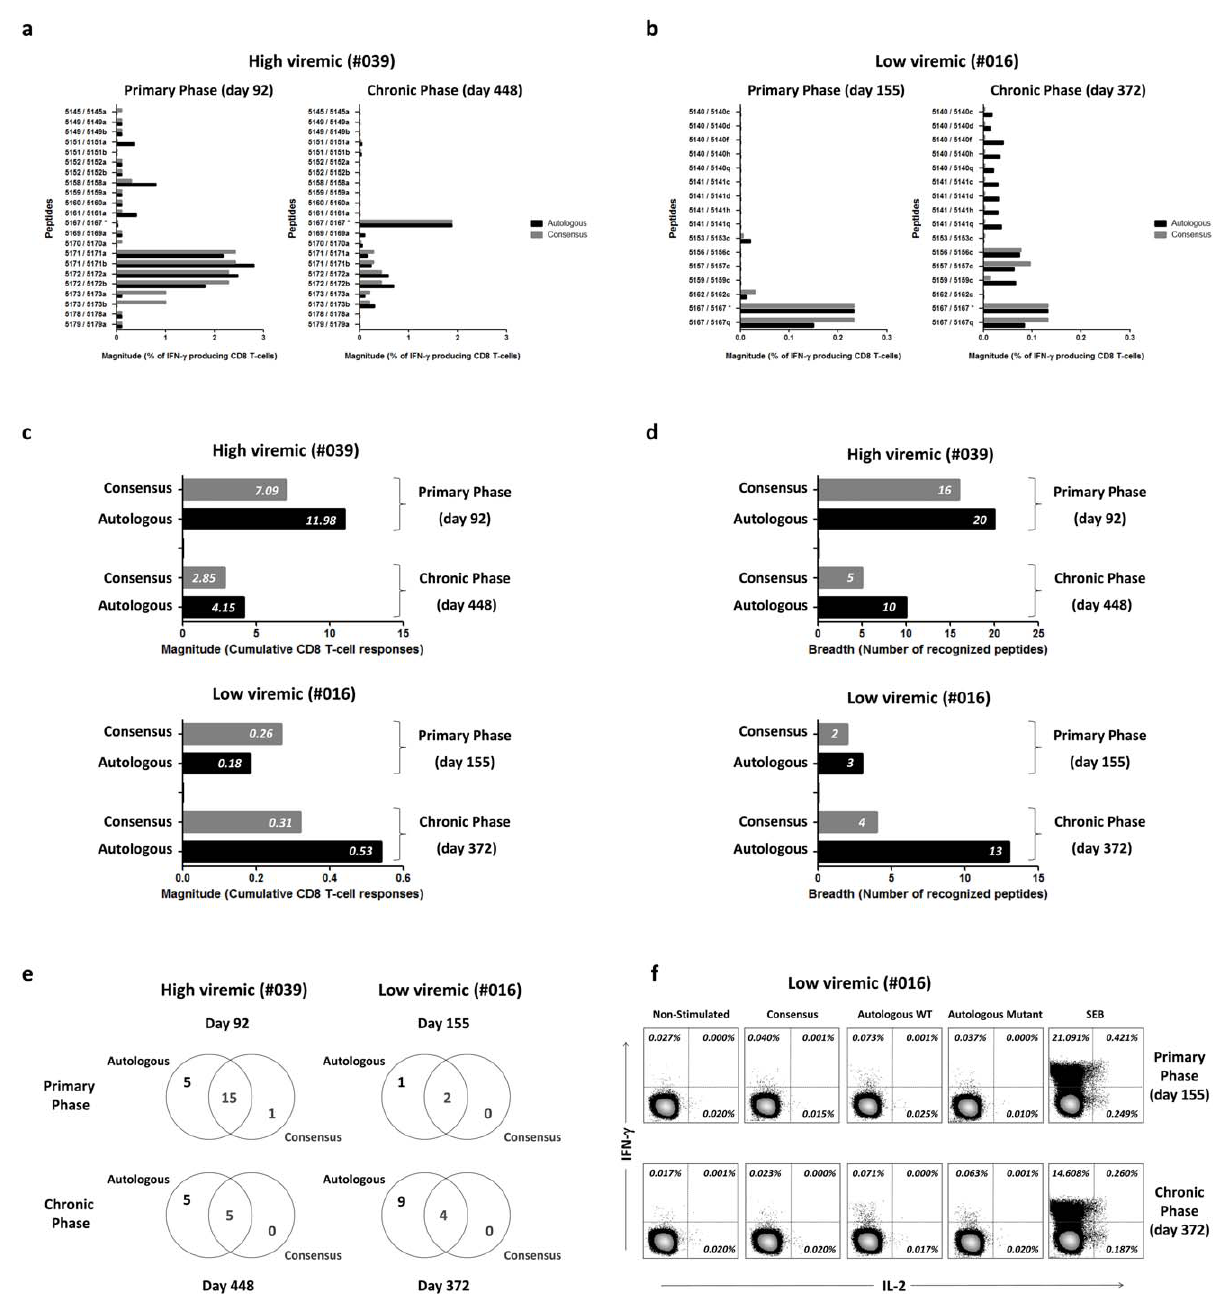
Figure 2. Breadth and magnitude of CD8 + T-cell IFN- c responses to clade-B consensus and autologous HIV-1 Nef peptides. Frequencies and magnitudes of total Nef-specific CD8 + T-cell IFN- c response to consensus and autologous HIV-Nef peptides by consensus peptides in high viremic subject (a) and low viremic subject (b). A decrease ( # 039) and an increase ( # 016) in the breadth of CD8 + T-cell responses to both consensus and autologous HIV-Nef sequences is shown during transition from primary (T1) to chronic (T2) infection. For high viremic subject, letter ‘‘a’’ in front of the peptide shows that the peptide belongs to visit 01 virus and letter ‘‘b’’ shows that the peptide belongs to visit 08 virus. For the low viremic subject, letters ‘‘c, d, f, and h’’ in front of the peptide shows that the peptide belongs to visit 01 virus and letter ‘‘q’’ shows that the peptide belongs to visit 10 virus. The asterisk shows that the consensus and the autologous peptides had similar a. a. sequences. CD8 + T-cells (%) producing IFN- c upon stimulation with consensus and autologous HIV-Nef sequences are shown. Only high responses ( . 0.1 for # 039 and . 0.01 for # 016) are shown. (c) Total magnitude of Nef-specific T-cell responses in low viremic subject (top) and high viremic subject (bottom) directed at either consensus or autologous peptides. (d) Breadth of total anti-Nef responses detected, expressed as the number of recognized peptides. (e) Number of peptides that induced CD8 + T-cell IFN- c responses in either category of clade-B consensus or autologous HIV-1 Nef peptides, by phase of infection. (f) Divergent evolution of CD8 + IFN- c responses to consensus HIV-Nef peptide 5140 (WSKRSVVGWPTVRER), autologous WT HIV-Nef peptide 5140d (WSKRSVPGWNIIRER) and autologous mutant HIV-Nef peptide 5140q (WSKRGVPGWNTIRER) over time. Percentages of cytokine producing subpopulations in total CD8 + T-cells in low viremic subject are shown: Magnitude of IFN- c production versus the magnitude of IL-2 production (% of CD8 + T-cells) from PBMC following stimulation. The negative control=non-stimulated, positive control tube=(SEB) used Staphylococcus aureus Enterotoxin B superantigen as stimulant. Plots are gated on CD3 + CD8 + T-cells. doi:10.1371/journal.pone.0049562.g002 PLOS ONE |